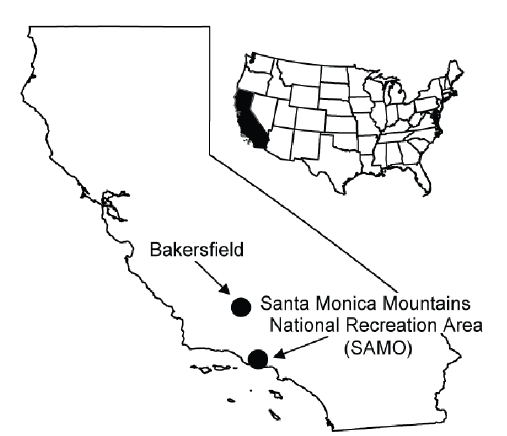
Fig. 2 . Study areas in California, USA, used for evaluation of urban rodent control behavior (adapted from Morzillo and Mertig 2011 b and Morzillo and Schwartz